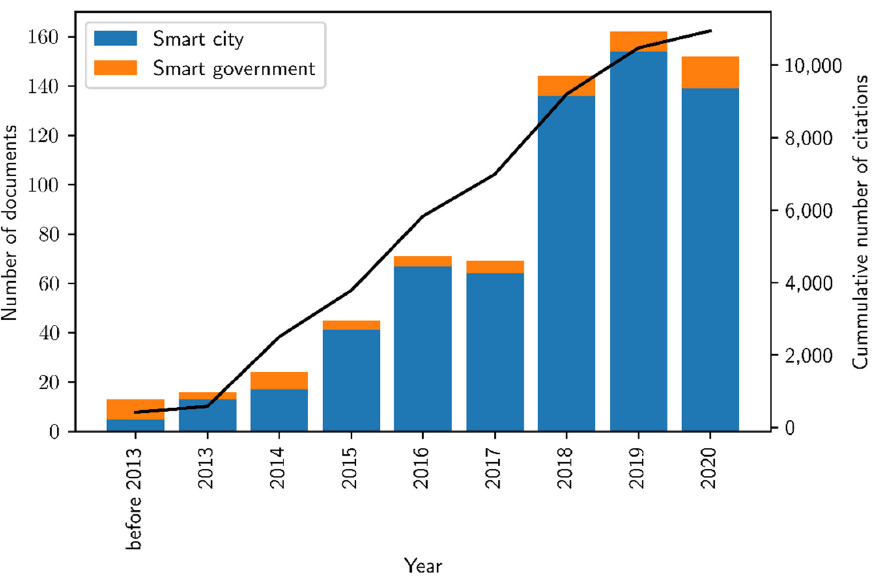
Figure 2. Distribution of publications and citations by year (2013–2020). Table 2. Most relevant documents by number of citations in SPG literature